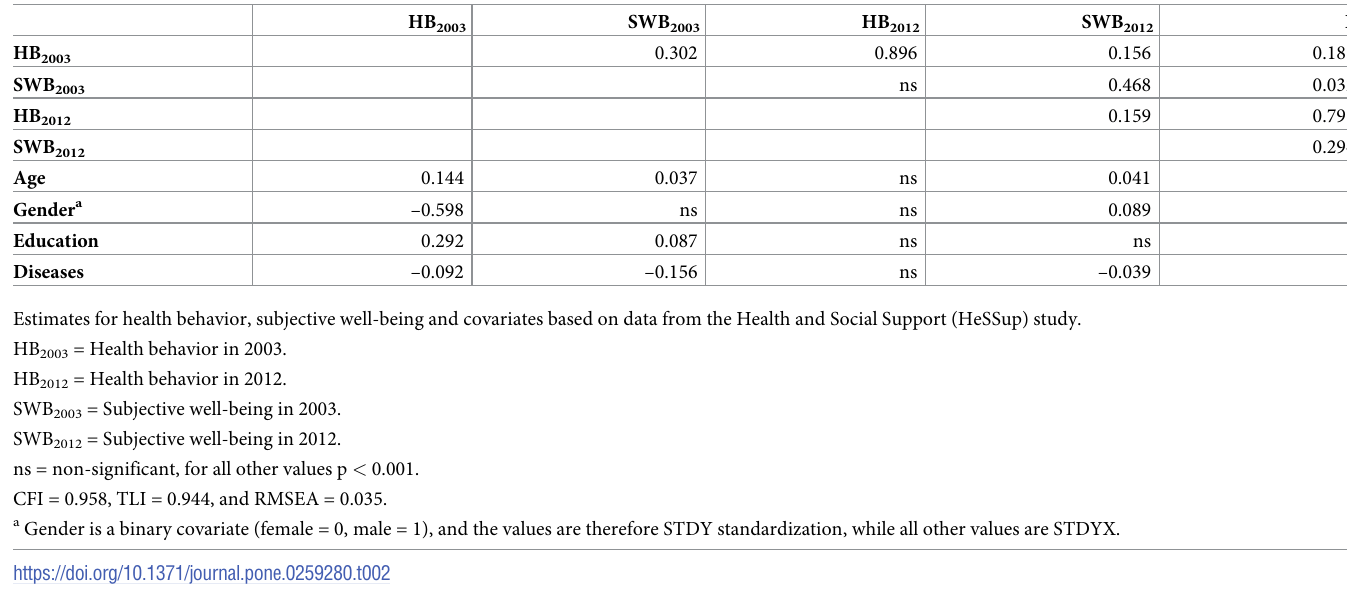
Table 2. Standardized path coefficients and R-values in the structural equation